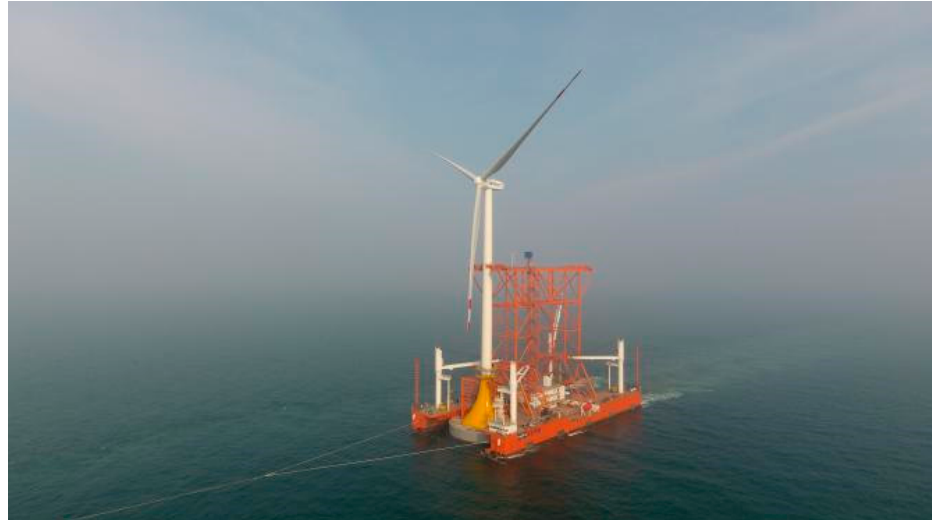
Figure 1. Jiangsu xiangshui 3 MW prototype.